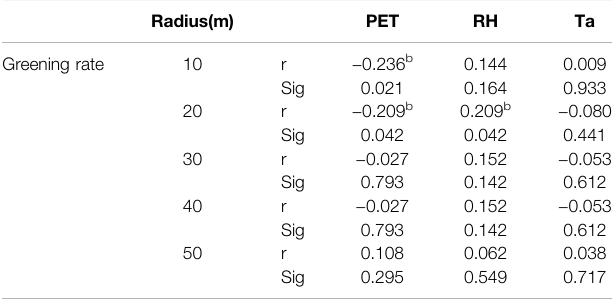
TABLE 5 | Correlation coef fi cients between greening rate and simulated data within different buffer radiuses. Radius(m) PET